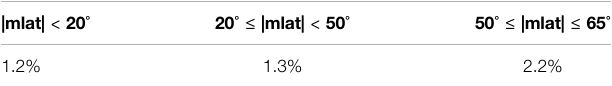
TABLE 3 | Relative differences in the waveguide ’ s effective height between 2005 and the solar minimum year of 2009 for low-, mid- and mid-high geomagnetic